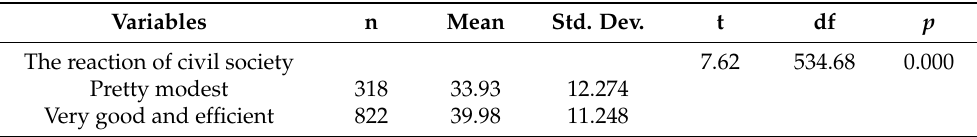
Table 5. The reaction of civil society/age of participants.